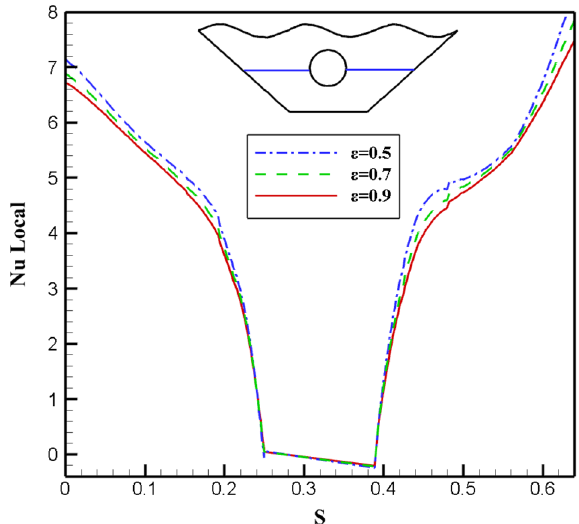
Figure 9. Local Nu number plot for different porosity ( ℇ ).